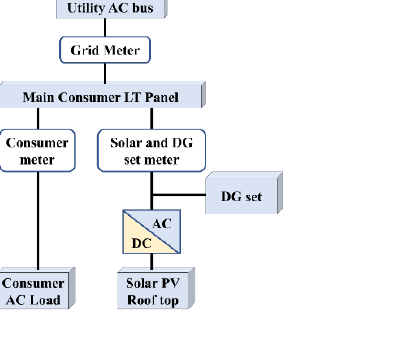
Figure 3: Net metering.